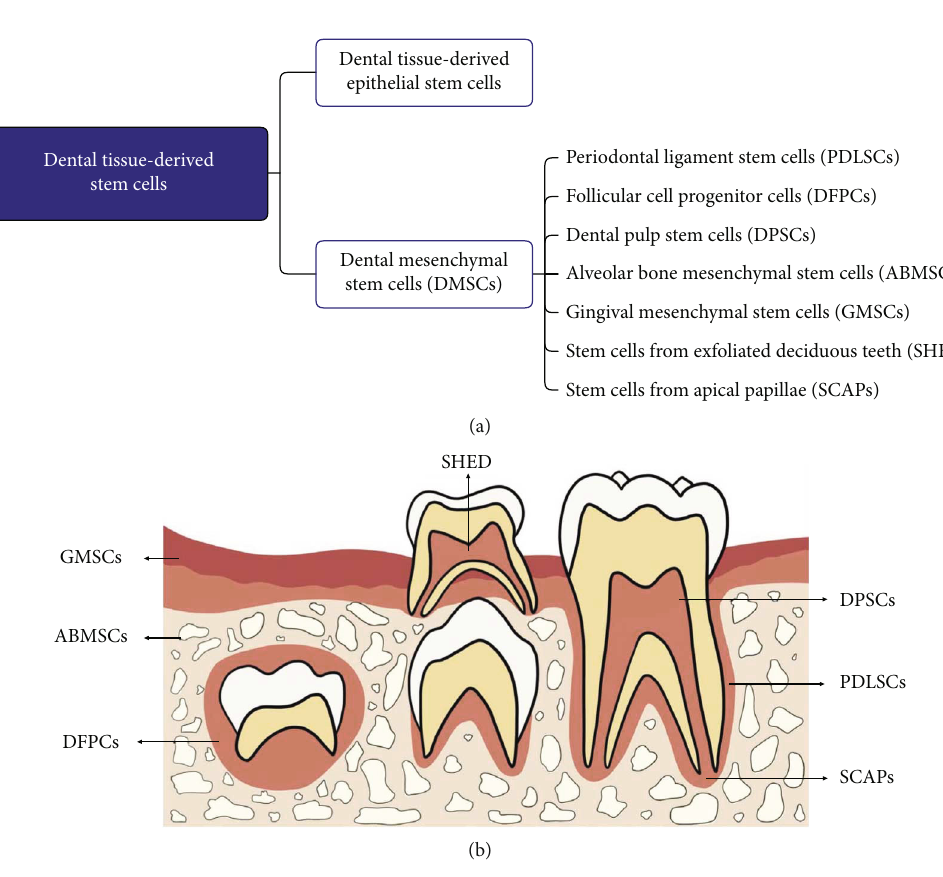
Figure 1: The di ff erent populations of dental tissue-derived stem cells and their distribution. Dental tissue-derived stem cells include dental mesenchymal stem cells and dental tissue-derived epithelial stem cells. DPSCs: dental pulp-derived stem cells; DFSCs: dental follicle stem cells; SCAPs: stem cells from apical papilla; PDLSCs: periodontal ligament stem cells; SHED: stem cells from exfoliated deciduous teeth GMSCs: stem cells from gingival tissue; ABMSCs: stem cells from the alveolar